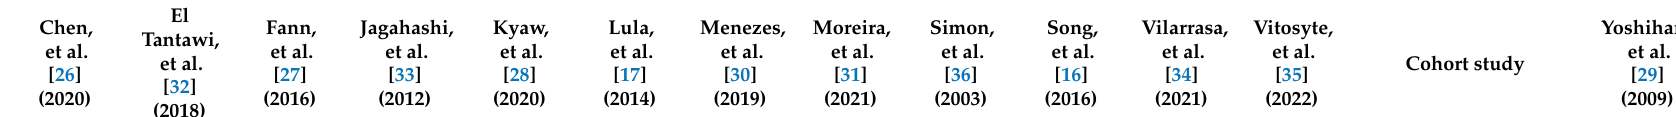
Table 2. Quality assessment of included articles using the Newcastle–Ottawa